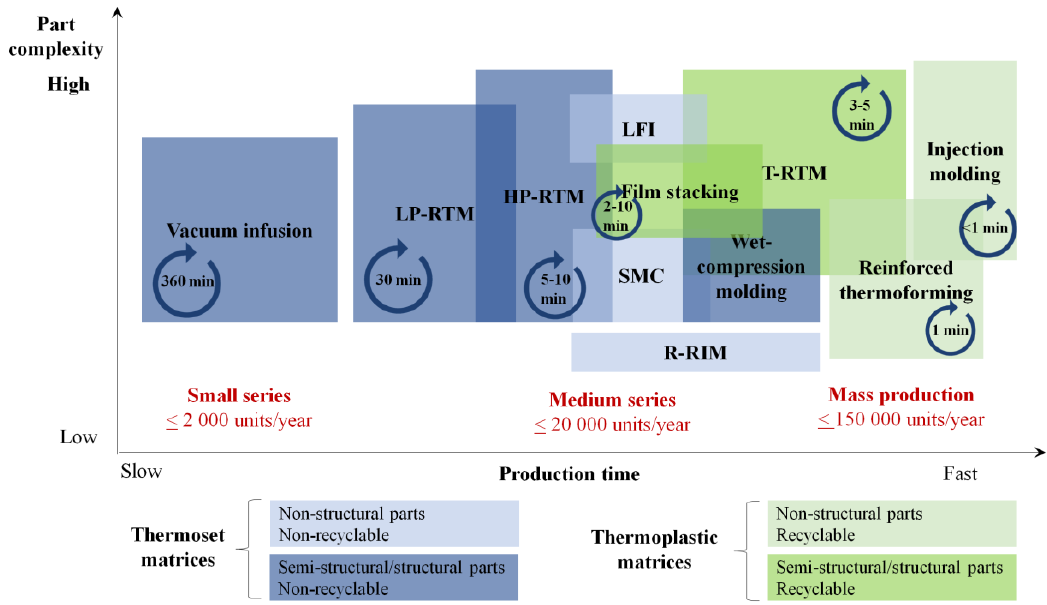
Figure 1. Comparison of various polymer composite production techniques (LP-RTM—Low Pressure Resin Transfer Molding; HP-RTM—High Pressure Resin Transfer Molding; LFI—Long Fiber Injection; SMC—Sheet Molding Compound; R-RIM—Reinforced Resin Injection Molding; T-RTM—Thermoplastic Resin Transfer Molding).